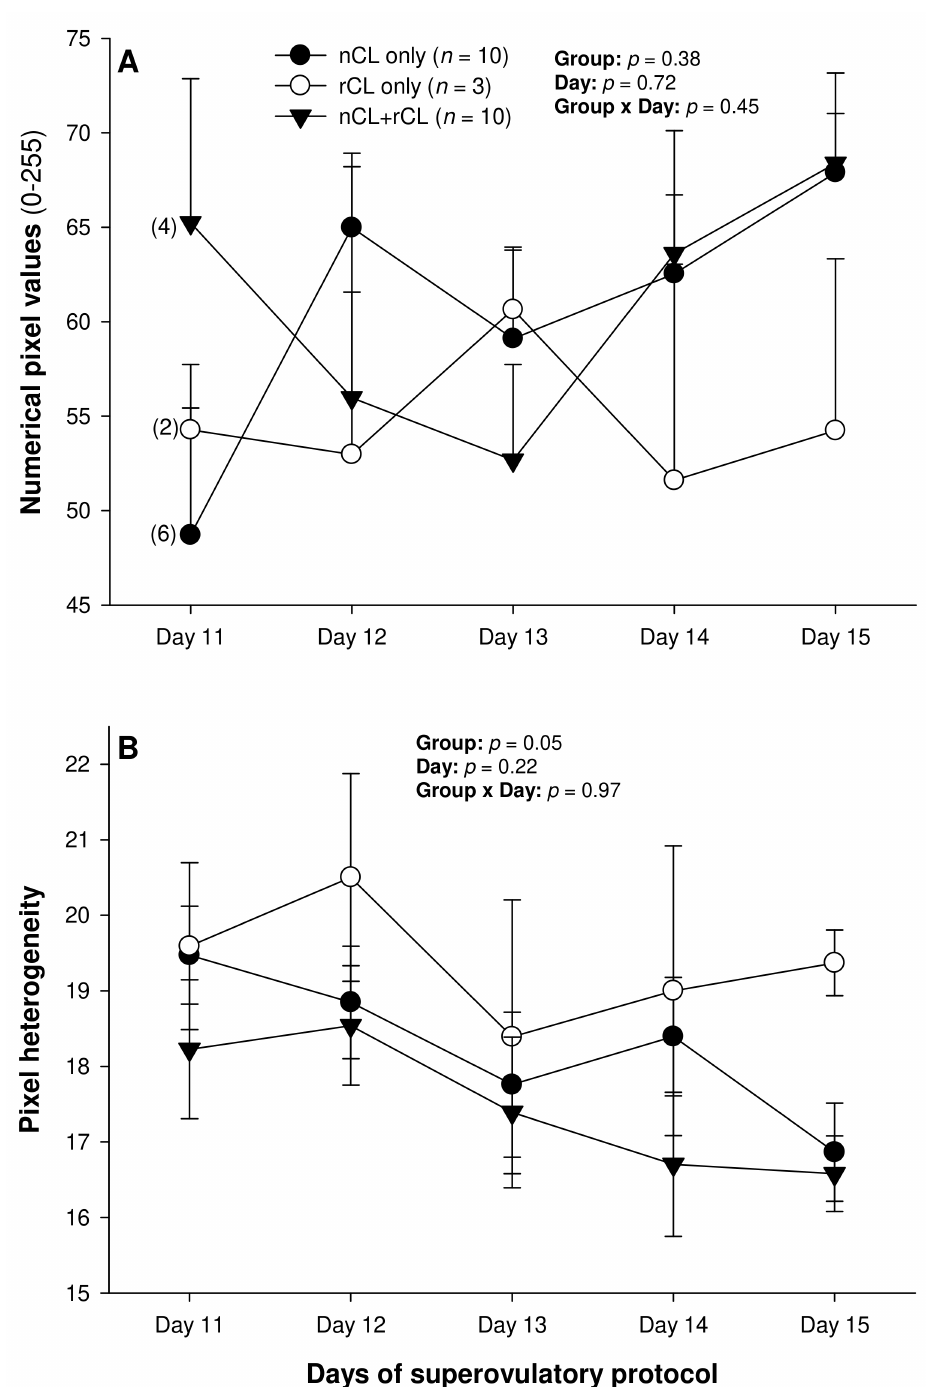
Figure 5. Mean ( ± SEM) numerical pixel values ( A ) and heterogeneity ( B ) of CL ultrasonograph- ically detected from Day 11 (1 or 2 days after ovulation or beginning of luteogenesis) to Day 15 (day of embryo recovery) of the superovulatory protocol in Santa In ê s ewes that had normal CL (nCL) only, regressing CL (rCL) only, or both nCL and rCL following the superovulatory pFSH treat- ment. Numbers in parentheses (panel A ) denote the numbers of ewes in which CL were detectable ultrasonographically on Day